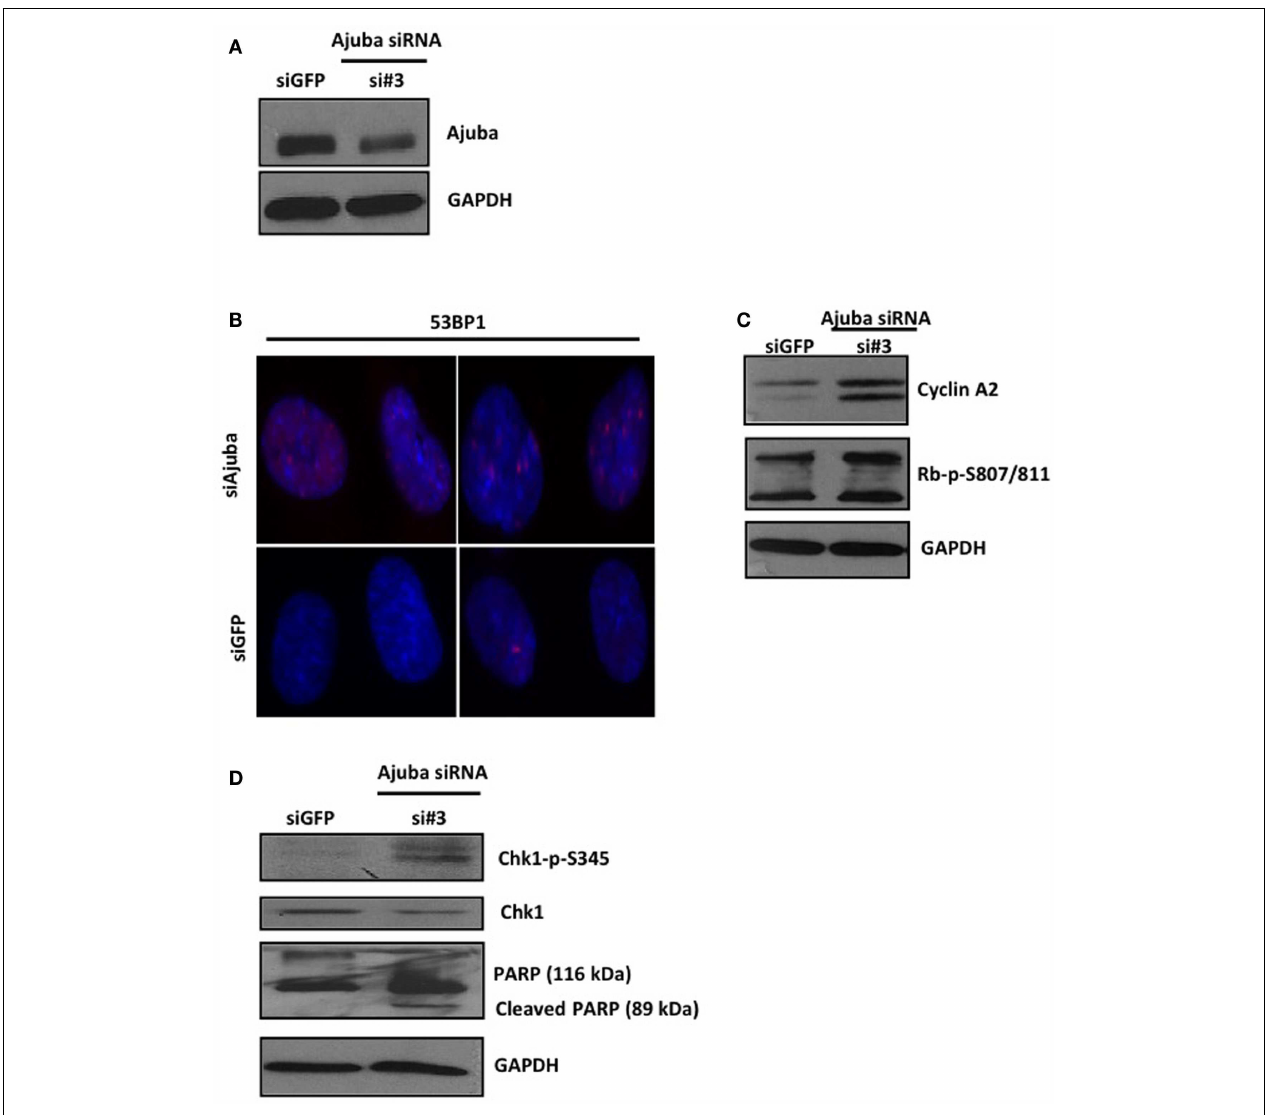
72h after transfection with siRNA #3.The loading controls with GAPDH for each blot are shown. (B) Staining for p53BP1 in Ajuba-depleted cells (siRNA#3), with siGFP as a